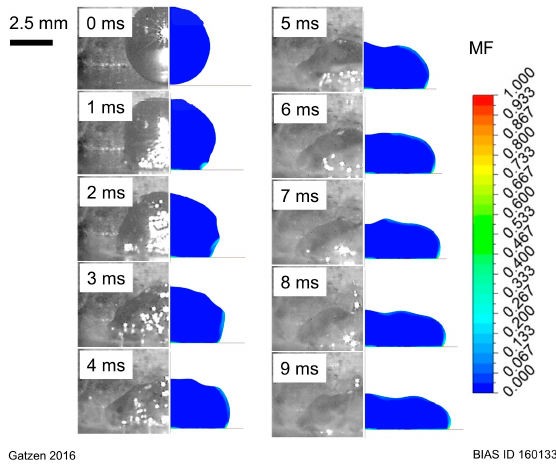
Figure 3. Droplet evolution on the zinc-coated surface, comparison between experiment and simulation.